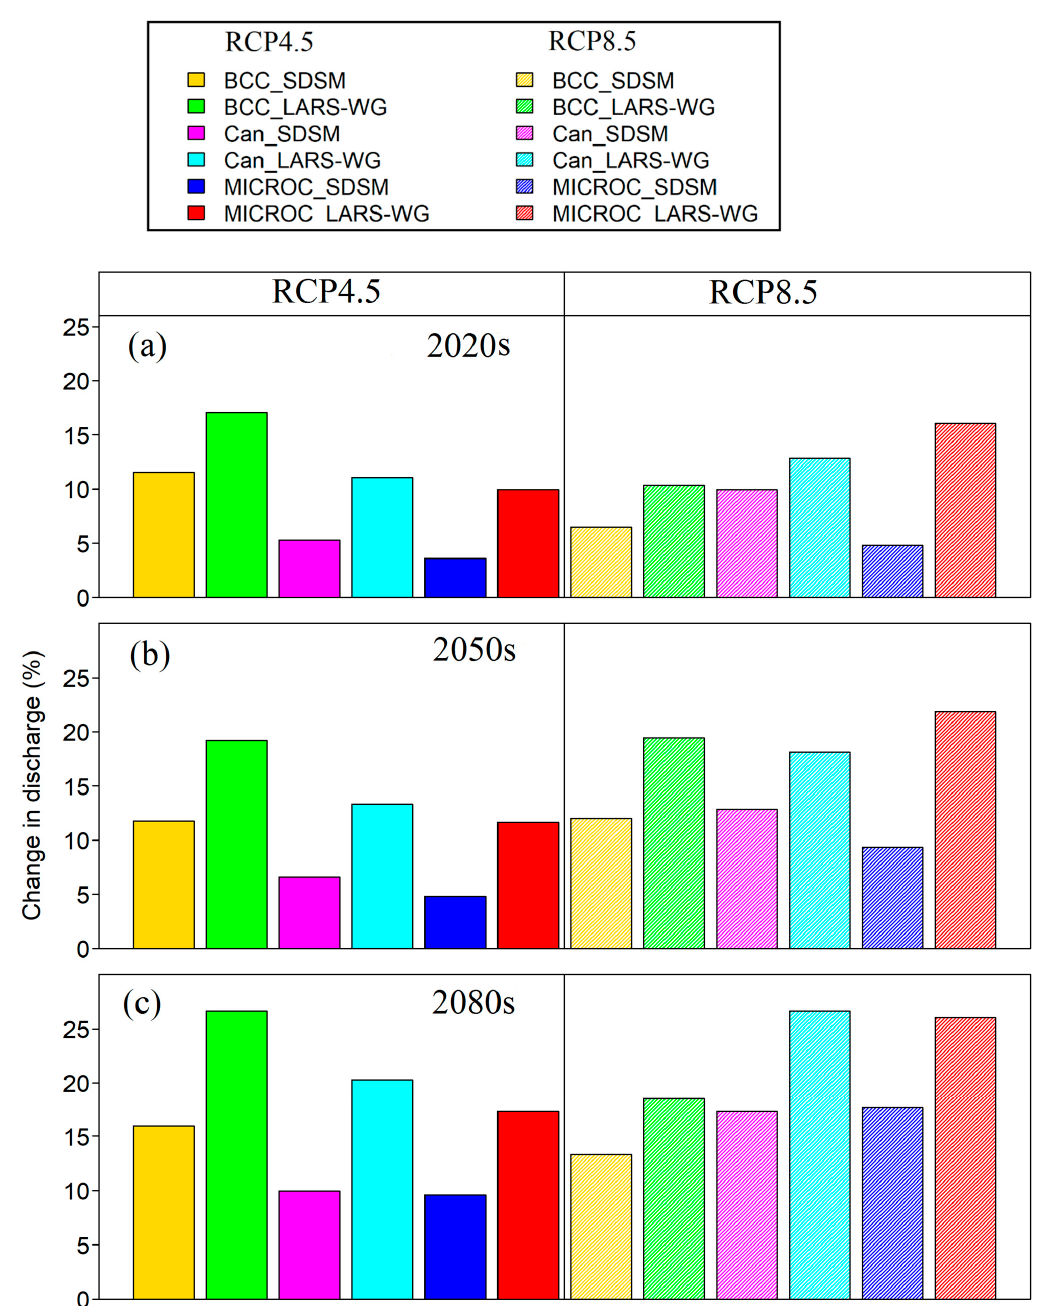
Figure 7. Annual runoff changes (%) relative to baseline simulations with SDSM and LARS-WG in three different time horizons ( a ) 2020s, ( b ) 2050s, and ( c ) 2080s and two RCPs.